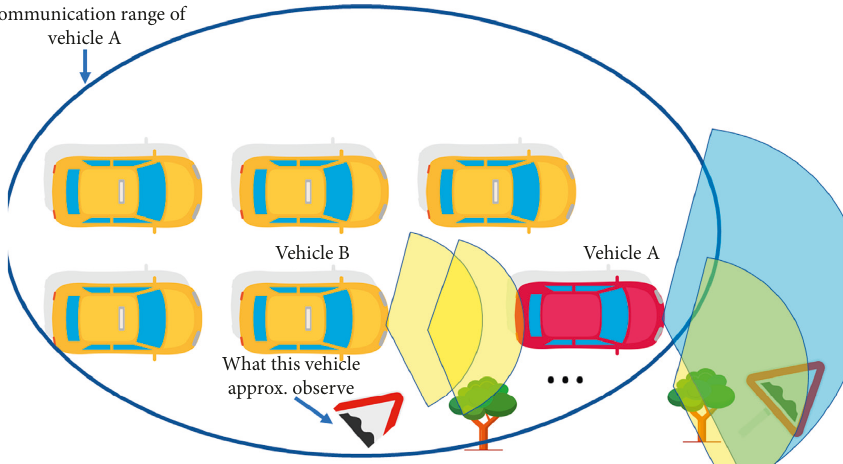
Figure 1: Illustration of the extended perception